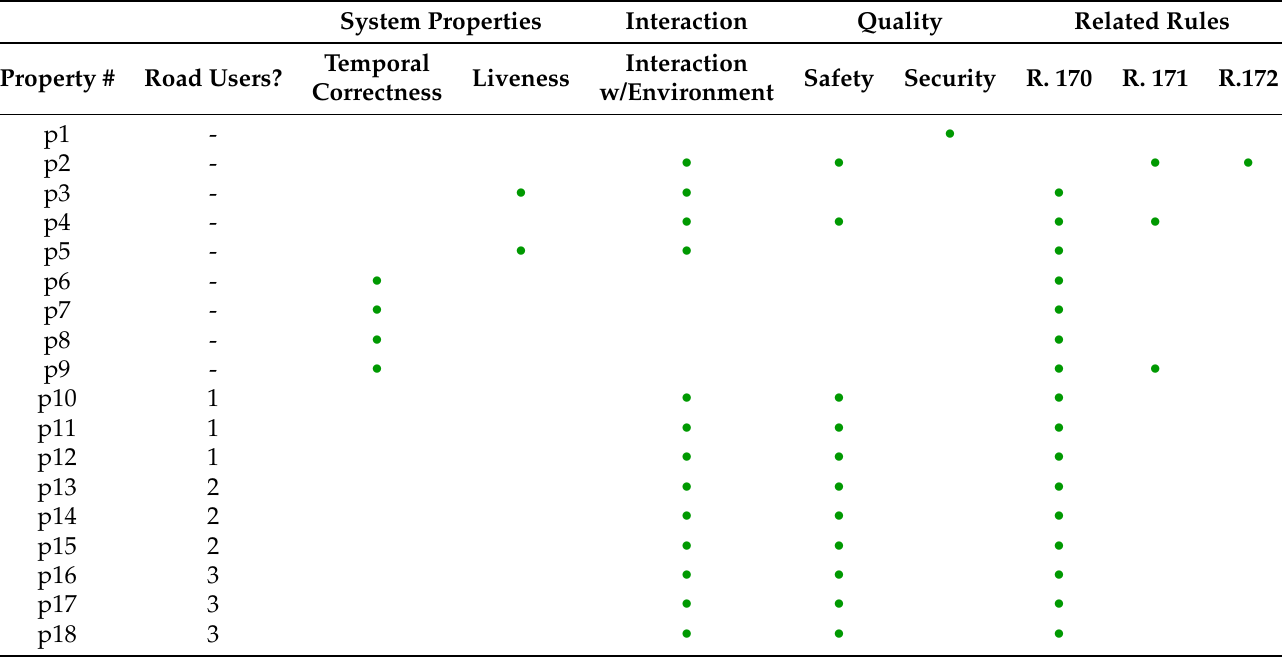
Table 5. Properties verified with UPPAAL